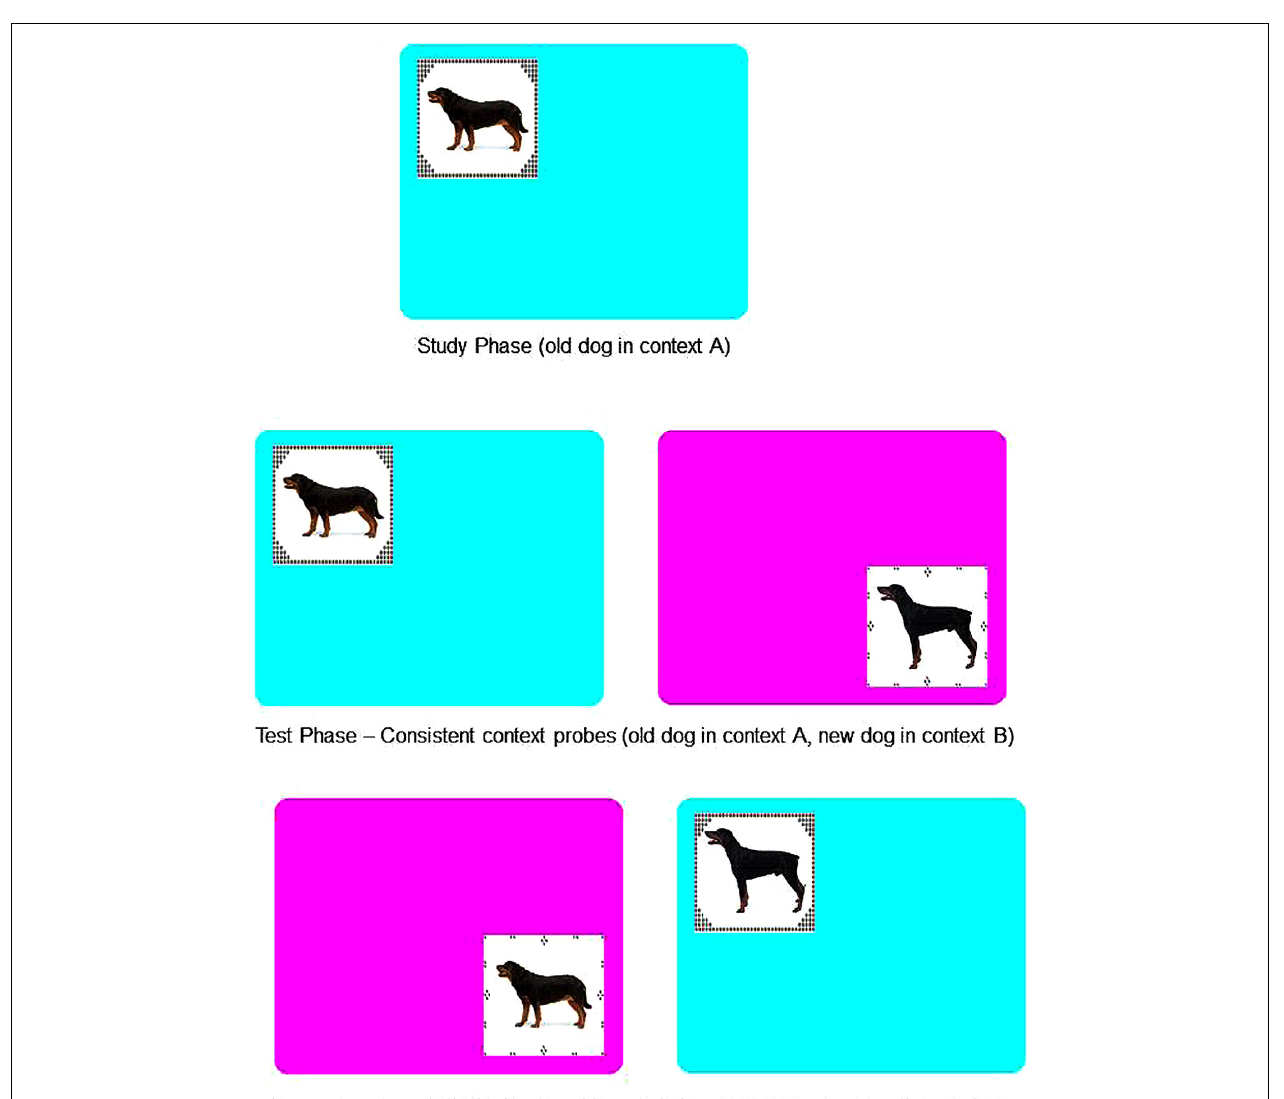
FIGURE 2 | Example of the context manipulation used in studies of recognition memory and induction.